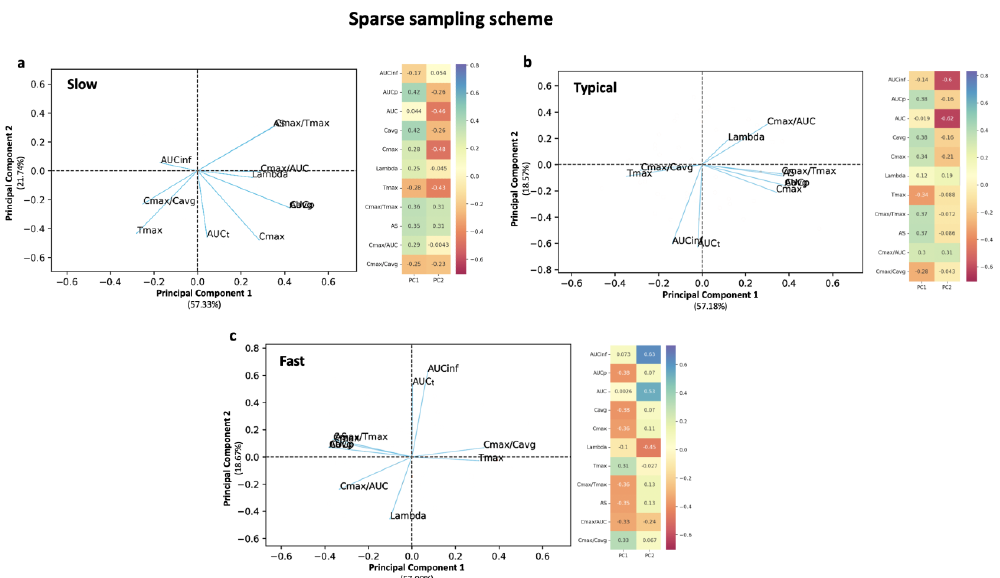
Figure A2. Principal component analysis for the pharmacokinetic parameters estimated from the simulated bioequivalence studies when a sparse sampling schedule (see Table 2) was utilized. The results refer to the three simulated conditions of slow 0.5× ( a ), typical 1× ( b ), and fast 2× absorption ( c ). The terms 0.5×, 1×, and 2× refer to the number of times the absorption rate constant used in simulations is greater or less than the one observed in actual data. Left panel: Biplot of the two principal components displaying the individual scores and the loadings (blue lines). Right panel: Loading values in the case of the first and second principal components (PC1 and PC2). A description of the pharmacokinetic parameters is provided in Table 1.